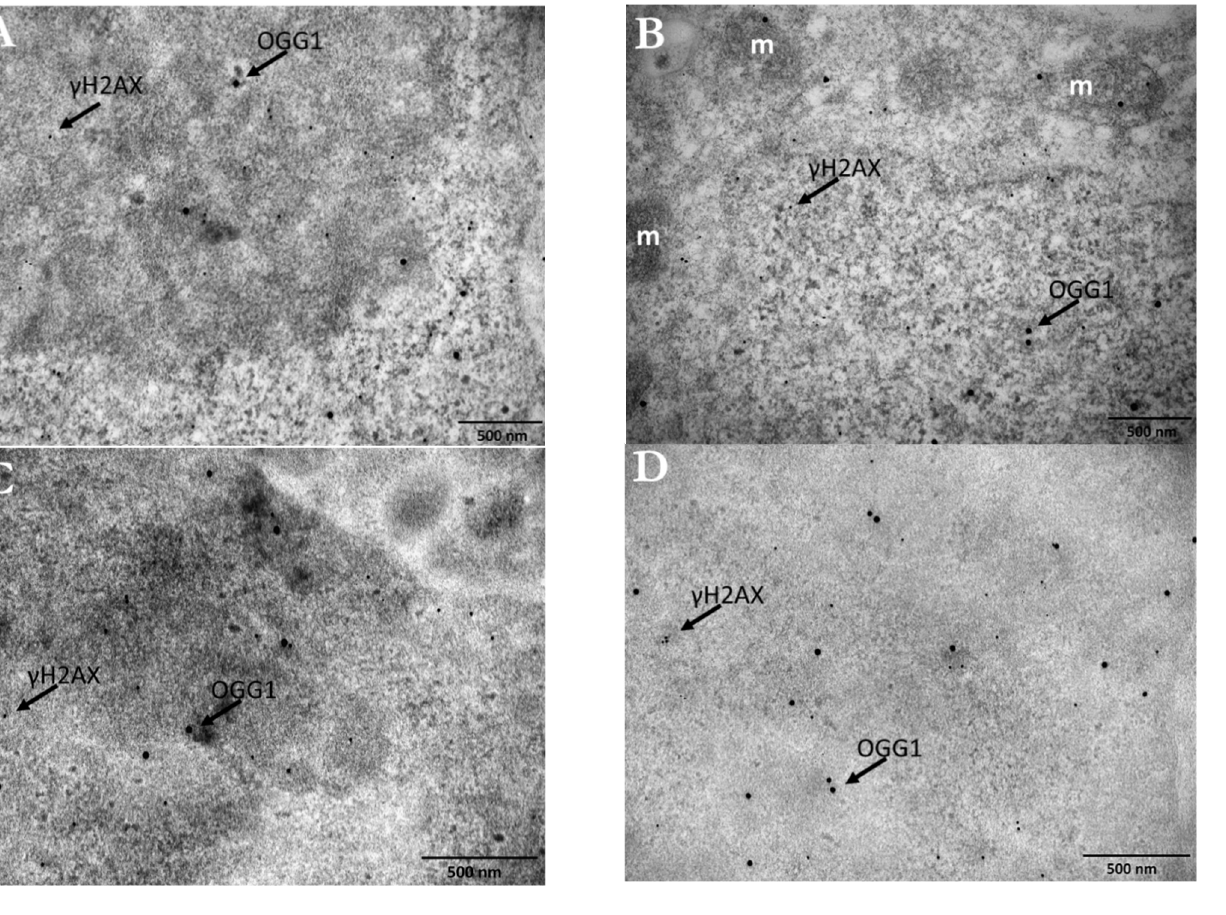
Figure 14. Electron micrographs of PC3 cells after immunogold labelling for DSBs and oxidative lesion detection. Images represent double immunolocalization for γ H2AX and OGG1 detection inside the nucleus, 0.5 h after 1Gy of IR exposure. The size of immunogold particles used for γ H2AX and OGG1 was 10 nm and 25 nm, respectively. Arrows in each image indicate the γ H2AX and OGG1 particles. ( A , B ) Images depict the detection of γ H2AX and OGG1 after irradiation but without treatment with AuNPs. m: mitochondrion. ( C , D ) Images depict the detection of γ H2AX and OGG1 after induced radiosensitization with 100 µ g/mL Ct-AuNPs (15